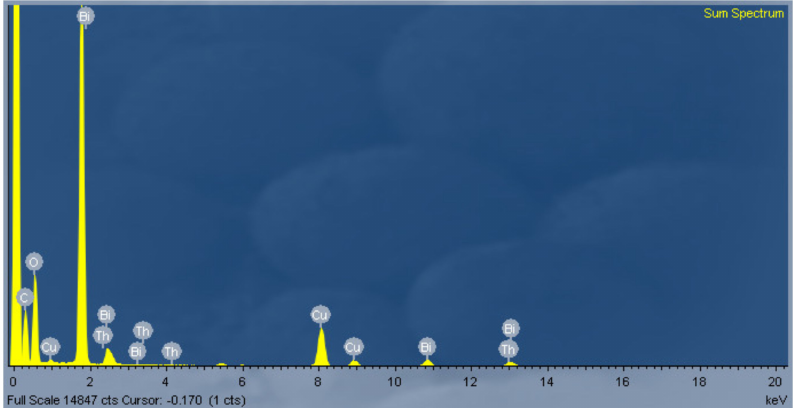
Figure 13. EDX spectrum of